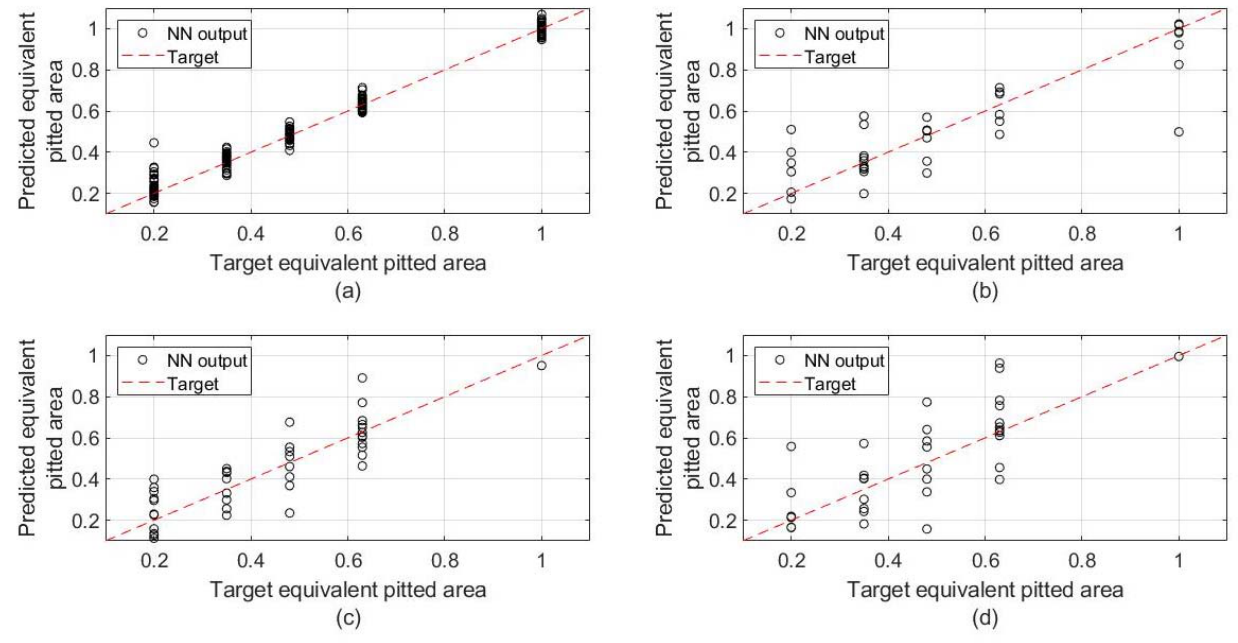
Figure 23. Quantification ANN performances: ( a ) training, ( b ) validation, ( c ) test with the correct damage location as input, and ( d ) test with the estimated damage location as input.